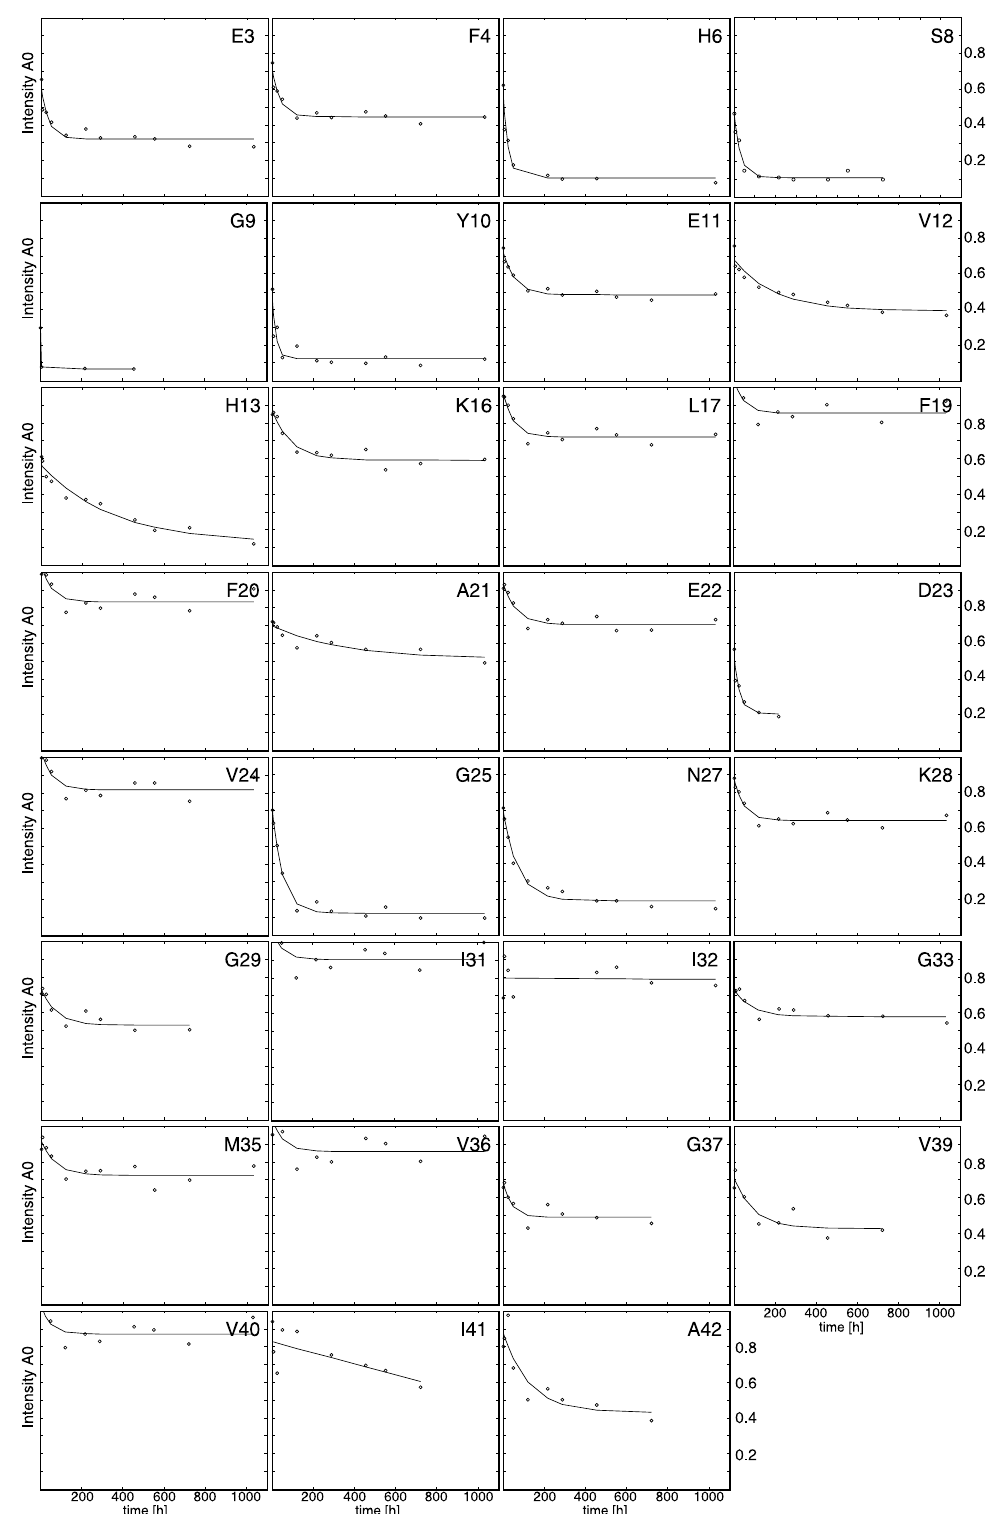
Fig 1. Residue-resolved quenched H/D exchange data for the identification of solvent protected 15 N- 1 H- moieties of A β (1–42)fibrils. The relative peak intensities of the [ 15 N, 1 H]-HMQC spectra (y-axis) acquiredin the DMSO solutionback predictedto time zero are shown for each exchangetime in D 2 O as indicatedalongthe x- axis. Smooth solid lines represent the mono- exponential fits of the data points. Some residues (for example:H6,